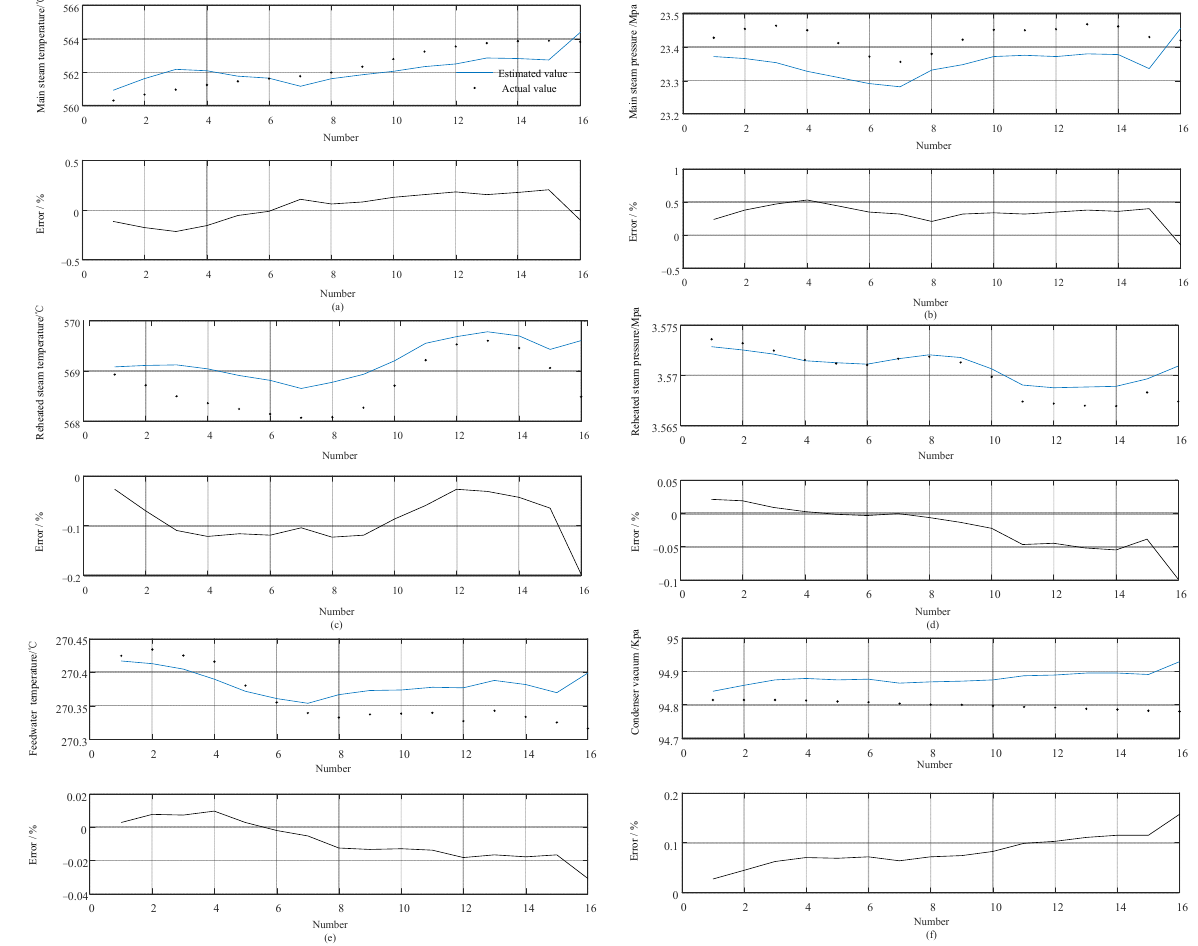
Figure 7. ( a ) The model test results of main steam temperature. ( b ) The model test results of main steam pressure. ( c ) The model test results of reheated steam temperature. ( d ) The model test results of reheated steam pressure. ( e ) The model test results of feedwater temperature. ( f ) The model test results of condenser vacuum.